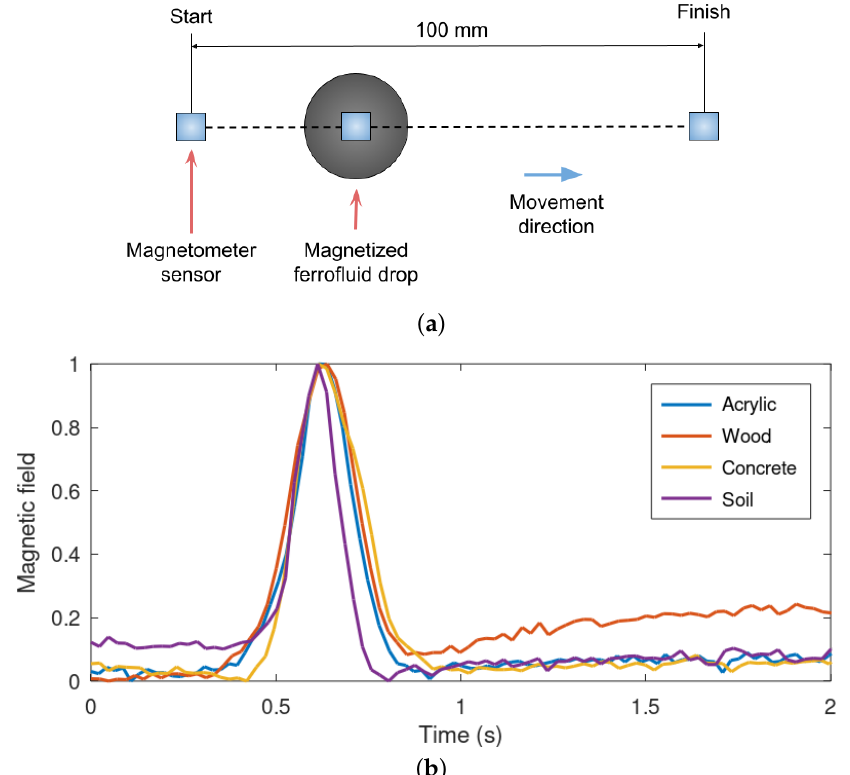
Figure 5. Magnetic field intensity measured on z axis of magnetometer while moving sensor and passing over a drop of pheromone. ( a ) Experimental set up: Sensor was moved 100 mm at 0.05 m/s speed and at 10 mm above surface level. Magnetic field was measured on the center of the drop. Reported environment temperature was 20 °C and 90% humidity. ( b ) Normalized magnetic field intensity results on z axis of magnetometer for different surfaces as a function of